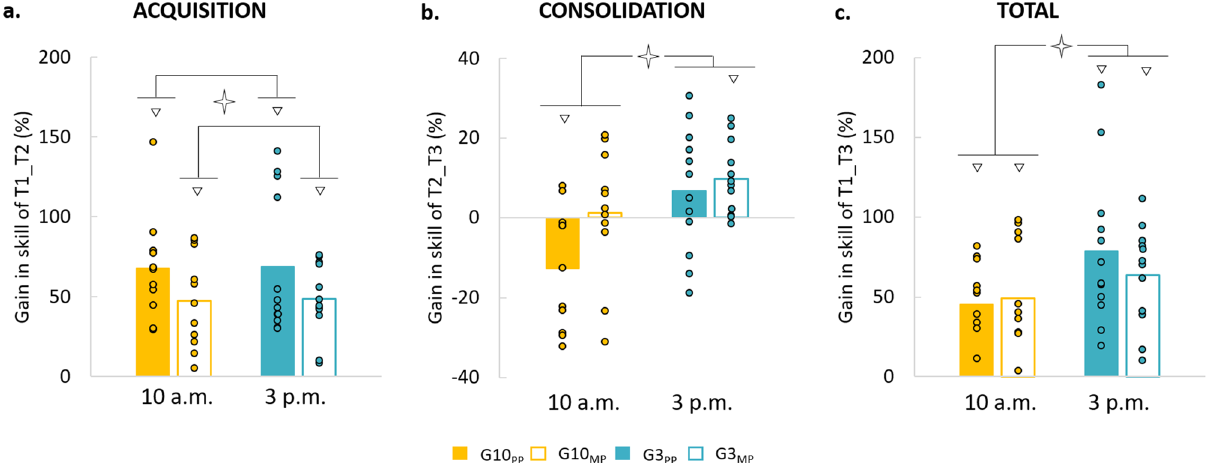
Figure 3. Average values (+ SE) of gains in skill performance (%) for the four groups. ( a ) Acquisition gains (T1_T2). ( b ) Consolidation gains (T2_T3). ( c ) Total gains (T1_T3). Circles indicate the individual gains of each participant. Open stars indicate significant differences between Practice or Time-of-day. White triangles indicate significant differences from the value